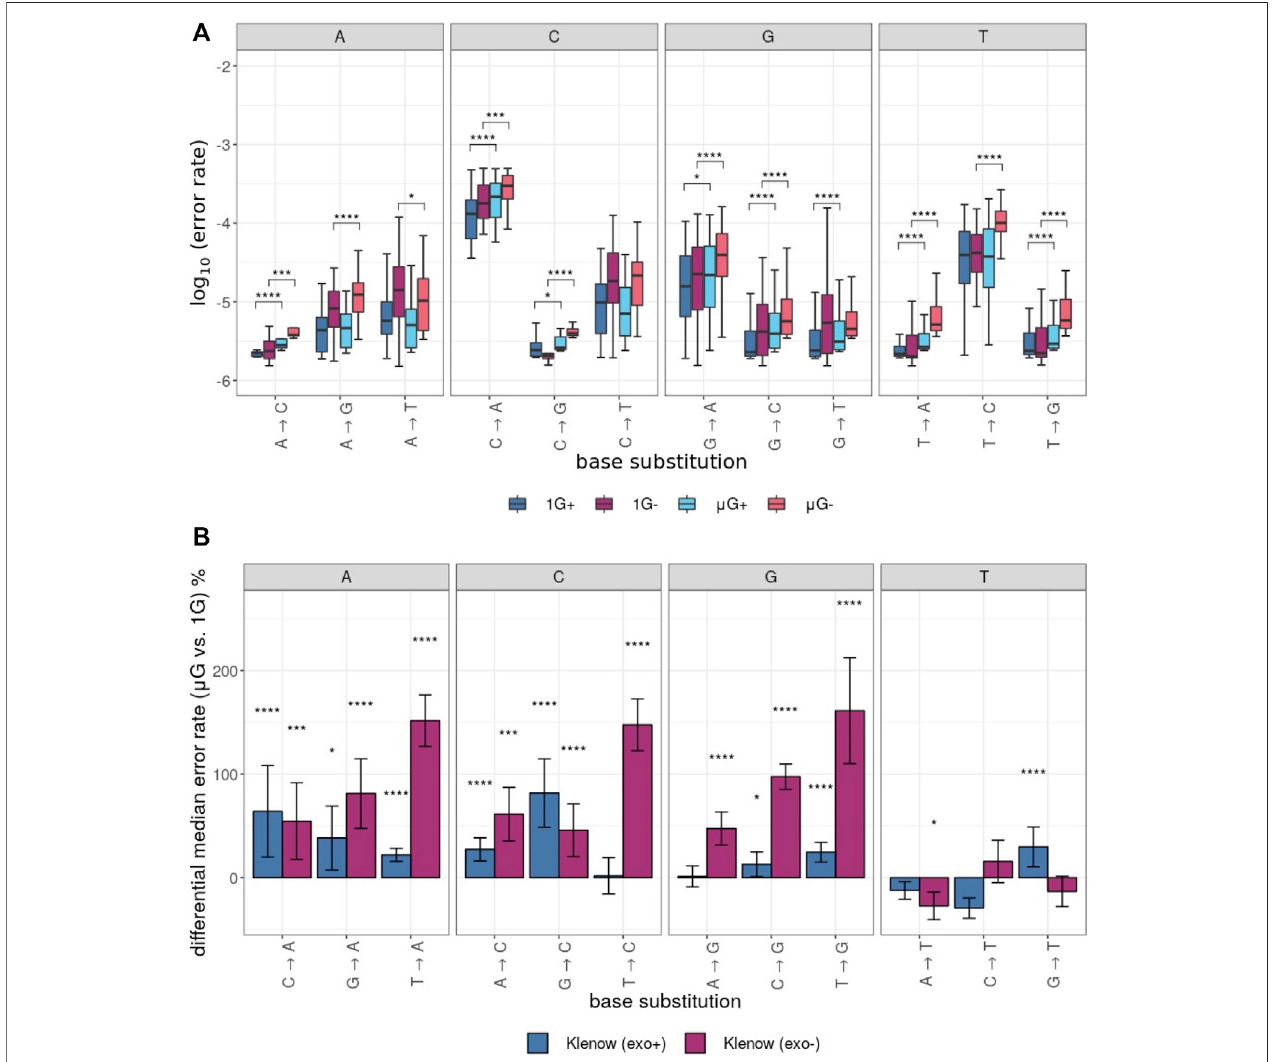
FIGURE 4 | Polymerase error rates interrogated by base substitution identity, including those exposed to either earth-like gravity (1 G) or microgravity ( μ G) conditionswith+and – referringtothepresenceorabsenceofexonucleaseproof-readingactivityintheKlenowfragmentpolymerase,respectively.Mann-WhitneyUtest p -value symbols are plotted above each boxplot for only thosecomparisons that were signi fi cantlydifferentwith p < 0.05 (cid:1) *, p < 0.01 (cid:1) **, p < 0.001 (cid:1) ***, p < 0.0001 (cid:1) ****. X → Ysubstitutions (where Xand Ysymbolize eitherC,G,TorAnucleotides)representreplacement ofXwithYonthetemplatesequence. (A) Boxplotsofthe log 10 error rates by sample and base substitution identity with individual clusters representing the identity of the template base. For each experimental condition, boxes are colored as noted in Figure 3 . (B). Differential median error rate percentage between gravitational conditions (1 G vs. µG) for each unique base substitution with individual clusters representing the identity of the substituted base. The superimposed error bars represent the standard deviation of each group.